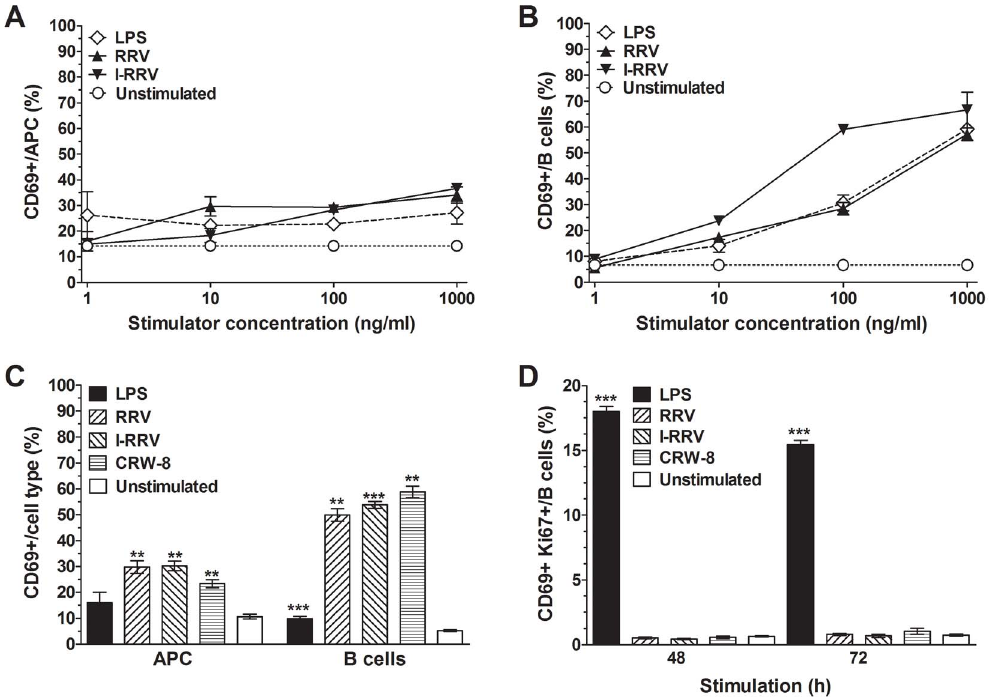
Figure 2. Rotavirus activation of APCs and B cells was dose-dependent and required brief virus exposure. CD69 expression on live APCs (A) and B cells (B) in NOD mouse splenocyte cultures was determined following their treatment for 24 h with the given concentrations of LPS, RRV or I-RRV. Control cultures were left unstimulated. (C) Proportions of activated live APCs and B cells after exposure of splenocytes to rotavirus, LPS or diluent (unstimulated) for 1 h, washing, replacement of medium and culture for a further 23 h. (D) Proportion of B cells expressing Ki67 and CD69 following LPS or rotavirus stimulation for 48 h and 72 h. Data are derived from one experiment and are representative of two independent experiments except for the data in D, which were derived from a single experiment. Error bars indicate the mean 6 SEM of 3 replicates. ** p , 0.01 and *** p , 0.001 compared with the respective unstimulated control.